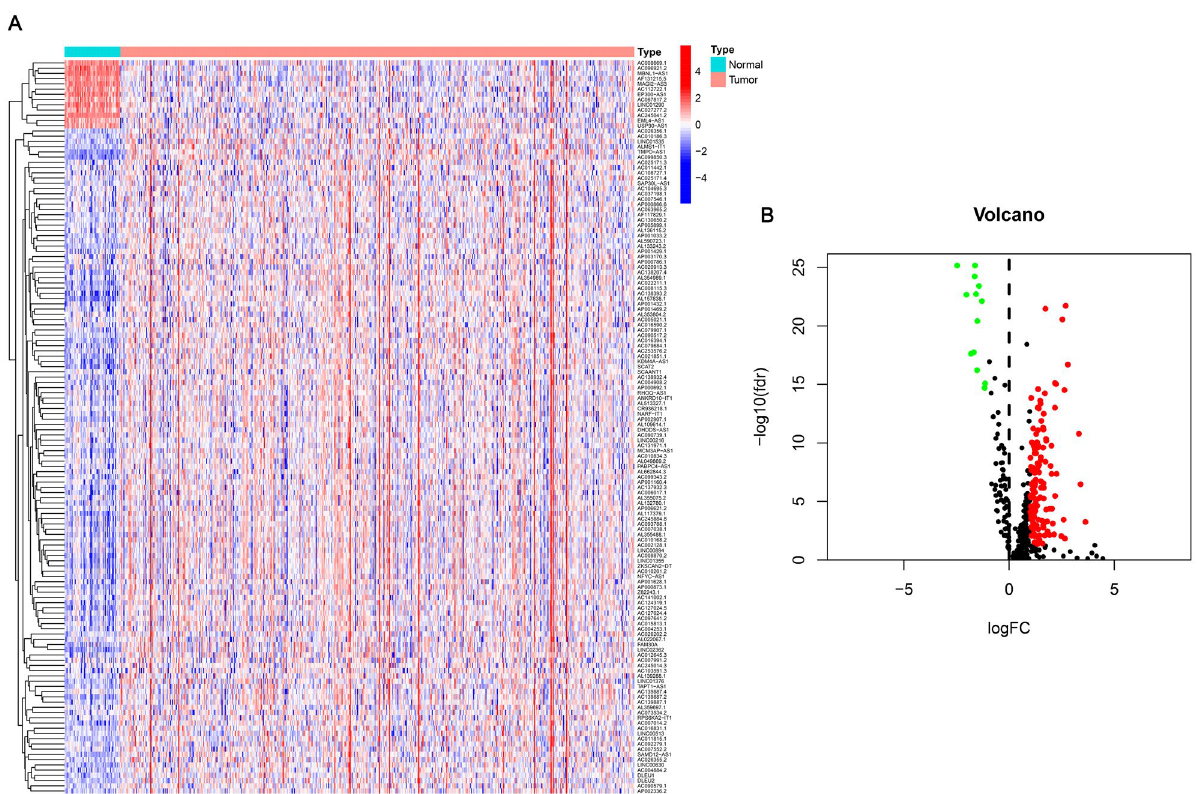
Figure 2. Heat map and differential expression analysis of necroptosis-related lncRNAs in LUAD. ( A ) Heat map of Necroptosis-related lncRNA genes of normal tissues and LUAD tissues. Upregulation is shown by Red, while blue downregulation is shown by Blue. ( B ) Necroptosis-related lncRNAs in LUAD together with normal tissue are shown as a volcano plot. Red dots: upregulated with significant differential expression; green dots: downregulated with significant differential expression; black dots: no significant difference.